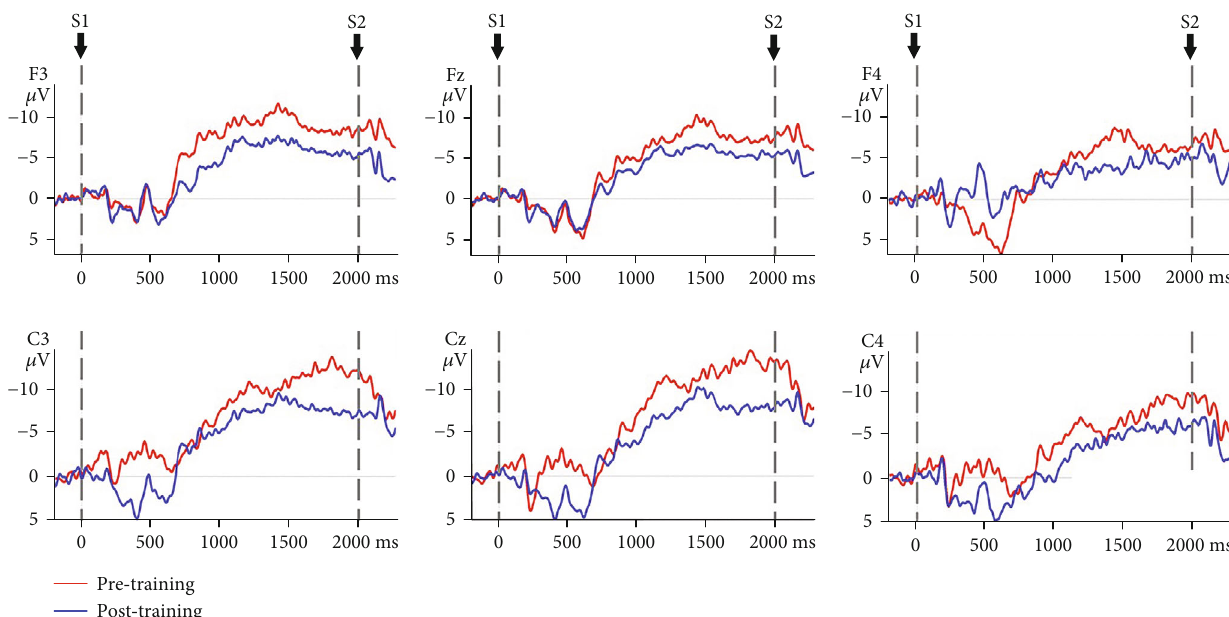
Figure 7: CNV amplitudes of the VR group during nonparetic hand movement. Note: negative is plotted upwards. The 200 ms epoch prior to the S1 onset was the baseline CNV amplitude. The onset is at 0ms point and is the S1 trigger time.